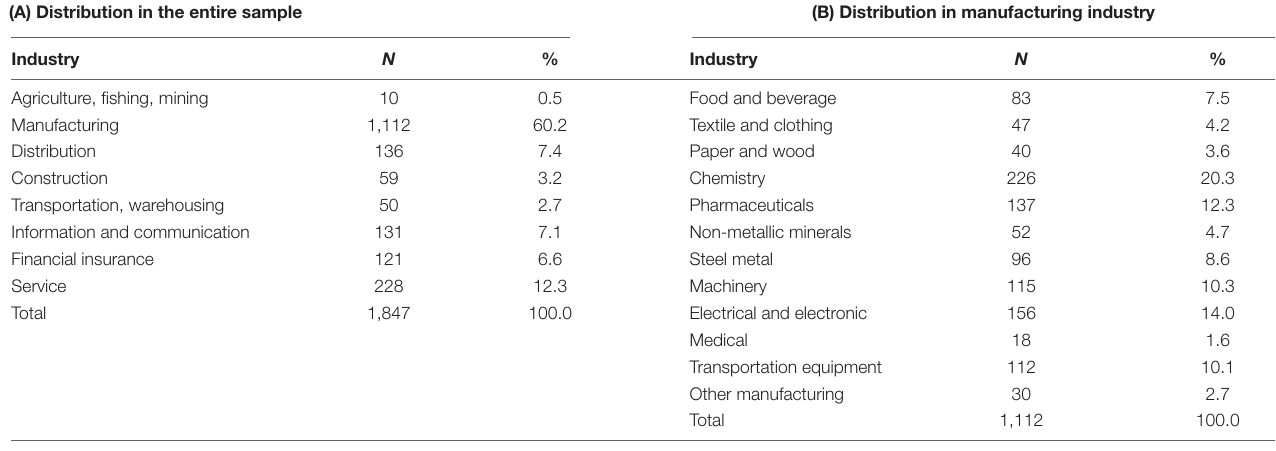
TABLE 2 | Distribution of sample by industry.